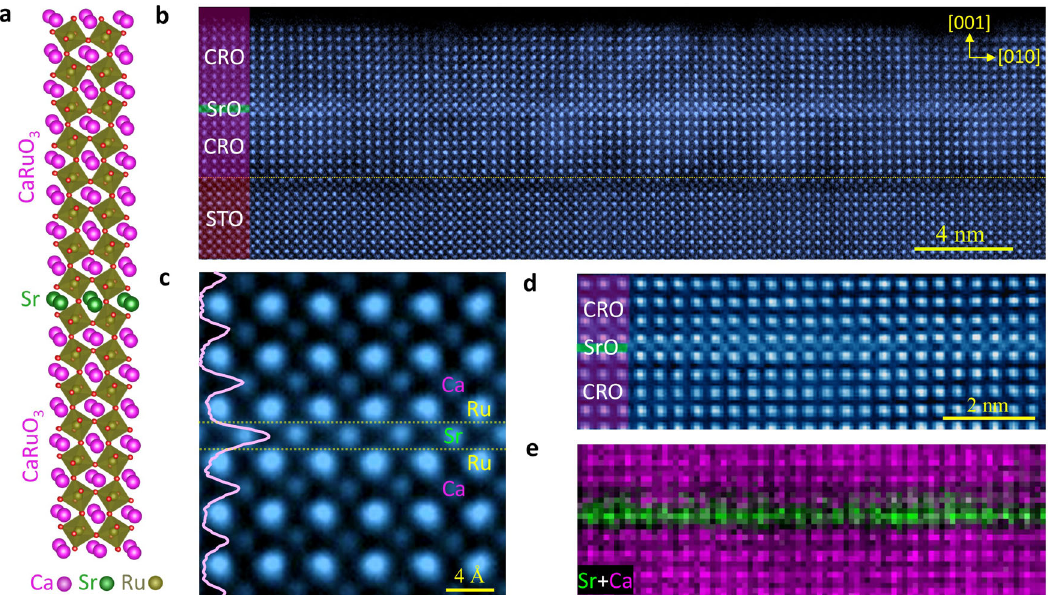
Fig. 1 Heterostructure design and atomic-scale visualization of CRO 7 -SrO-CRO 8 heterostructure. a Schematic of the nested SrO δ -doping in CaRuO 3 . Atomic-resolution high-angle annular dark- fi eld (HAADF) images of δ -doped CRO 7 -SrO-CRO 8 heterostructure: b large-area HAADF image, and c highly magni fi ed HAADF with superimposed intensity pro fi les of Ca/Sr layer. d Annular dark fi eld (ADF) image and e corresponding electron energy loss spectroscopy (EELS) mapping for Ca (purple) and Sr (green) cations. The electron beam is along the [100] direction of the STO